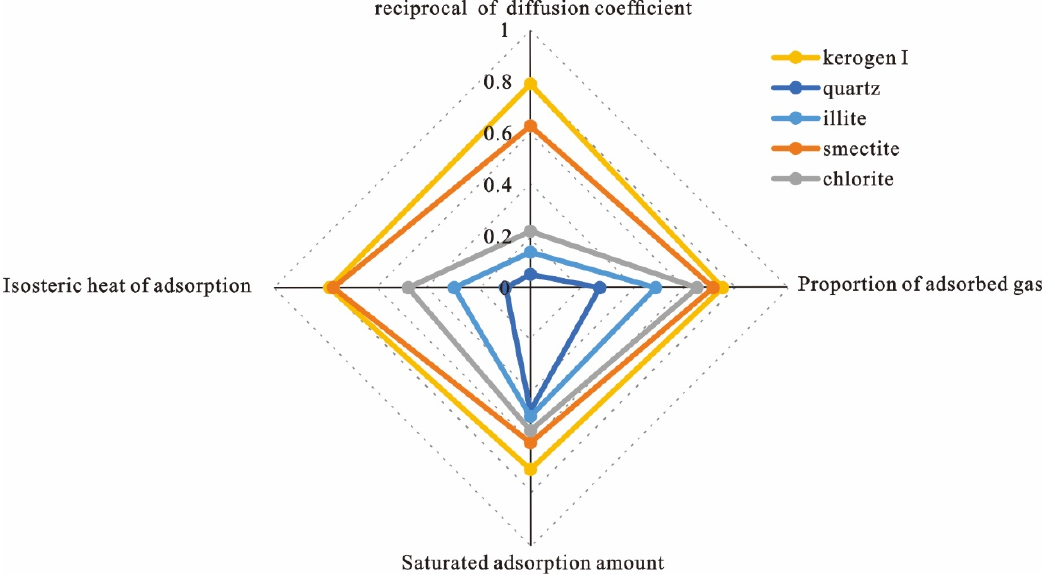
Figure 8. Comprehensive evaluation of adsorption capacity of different mineral matrix.